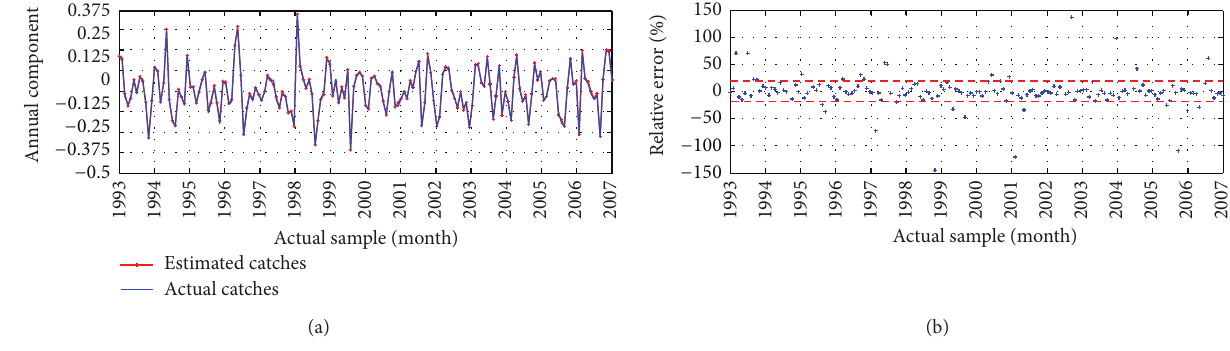
Figure 6: 10 -month-ahead WAR forecasting for annual component ( 𝑥 𝑎 ).